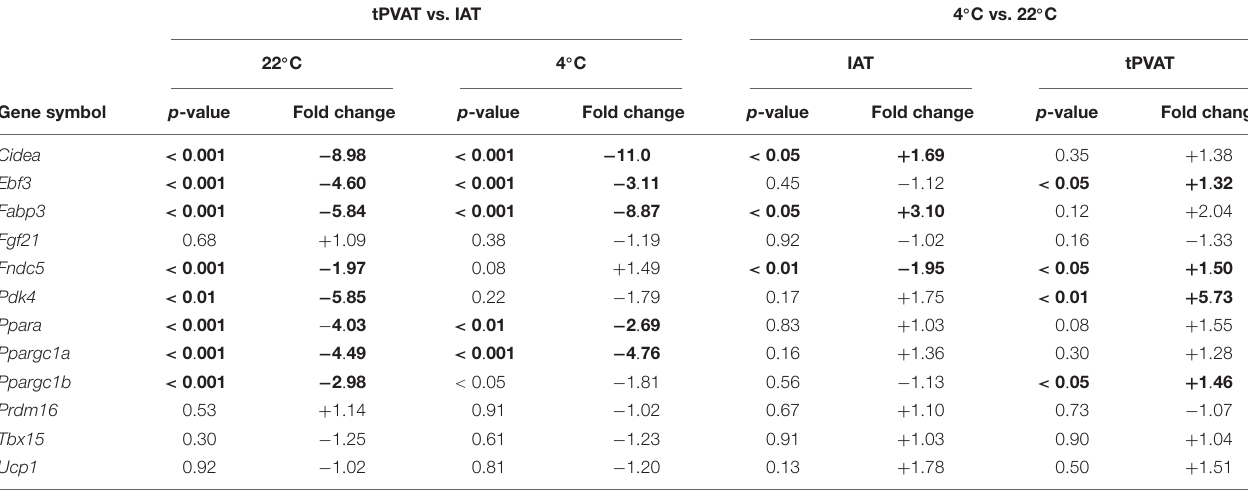
TABLE 2 | Comparison of gene expression of brown/brite adipocyte markers in tPVAT vs. IAT and in cold vs. control temperature (Student’s t -test). tPVAT vs. IAT